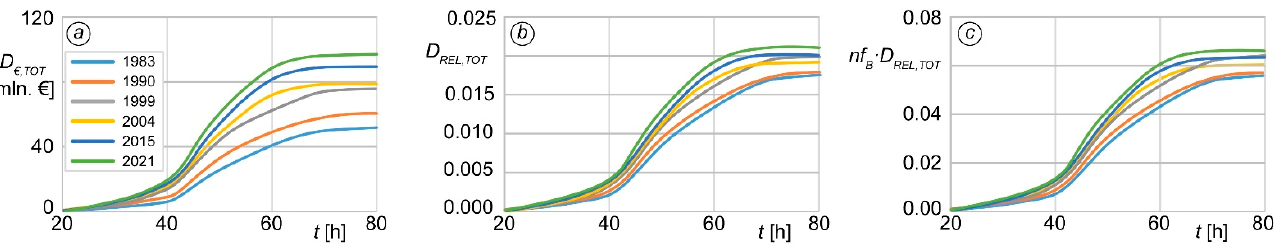
Figure 9. Temporal evolution of ( a ) the total damage D €,TOT , ( b ) the relative damage D REL,TOT , and ( c ) the relative damage referred to the ground floor, for residential buildings for the different layouts since 1983 to 2021.